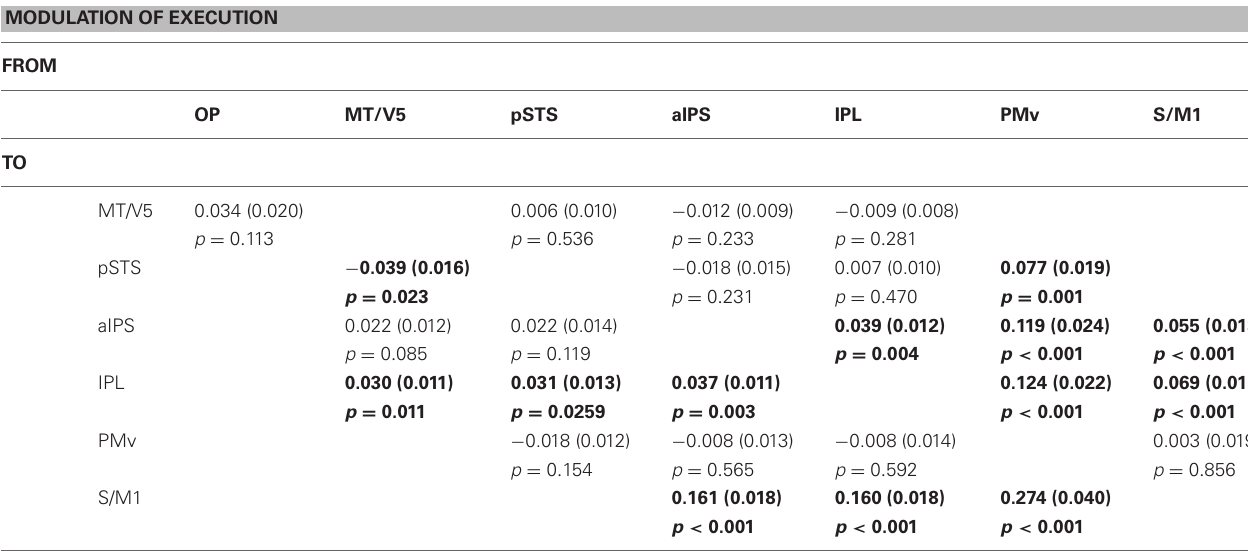
Table 8 | Results of one-sample t -test for coupling parameters of Execution modulation. MODULATION OF EXECUTION